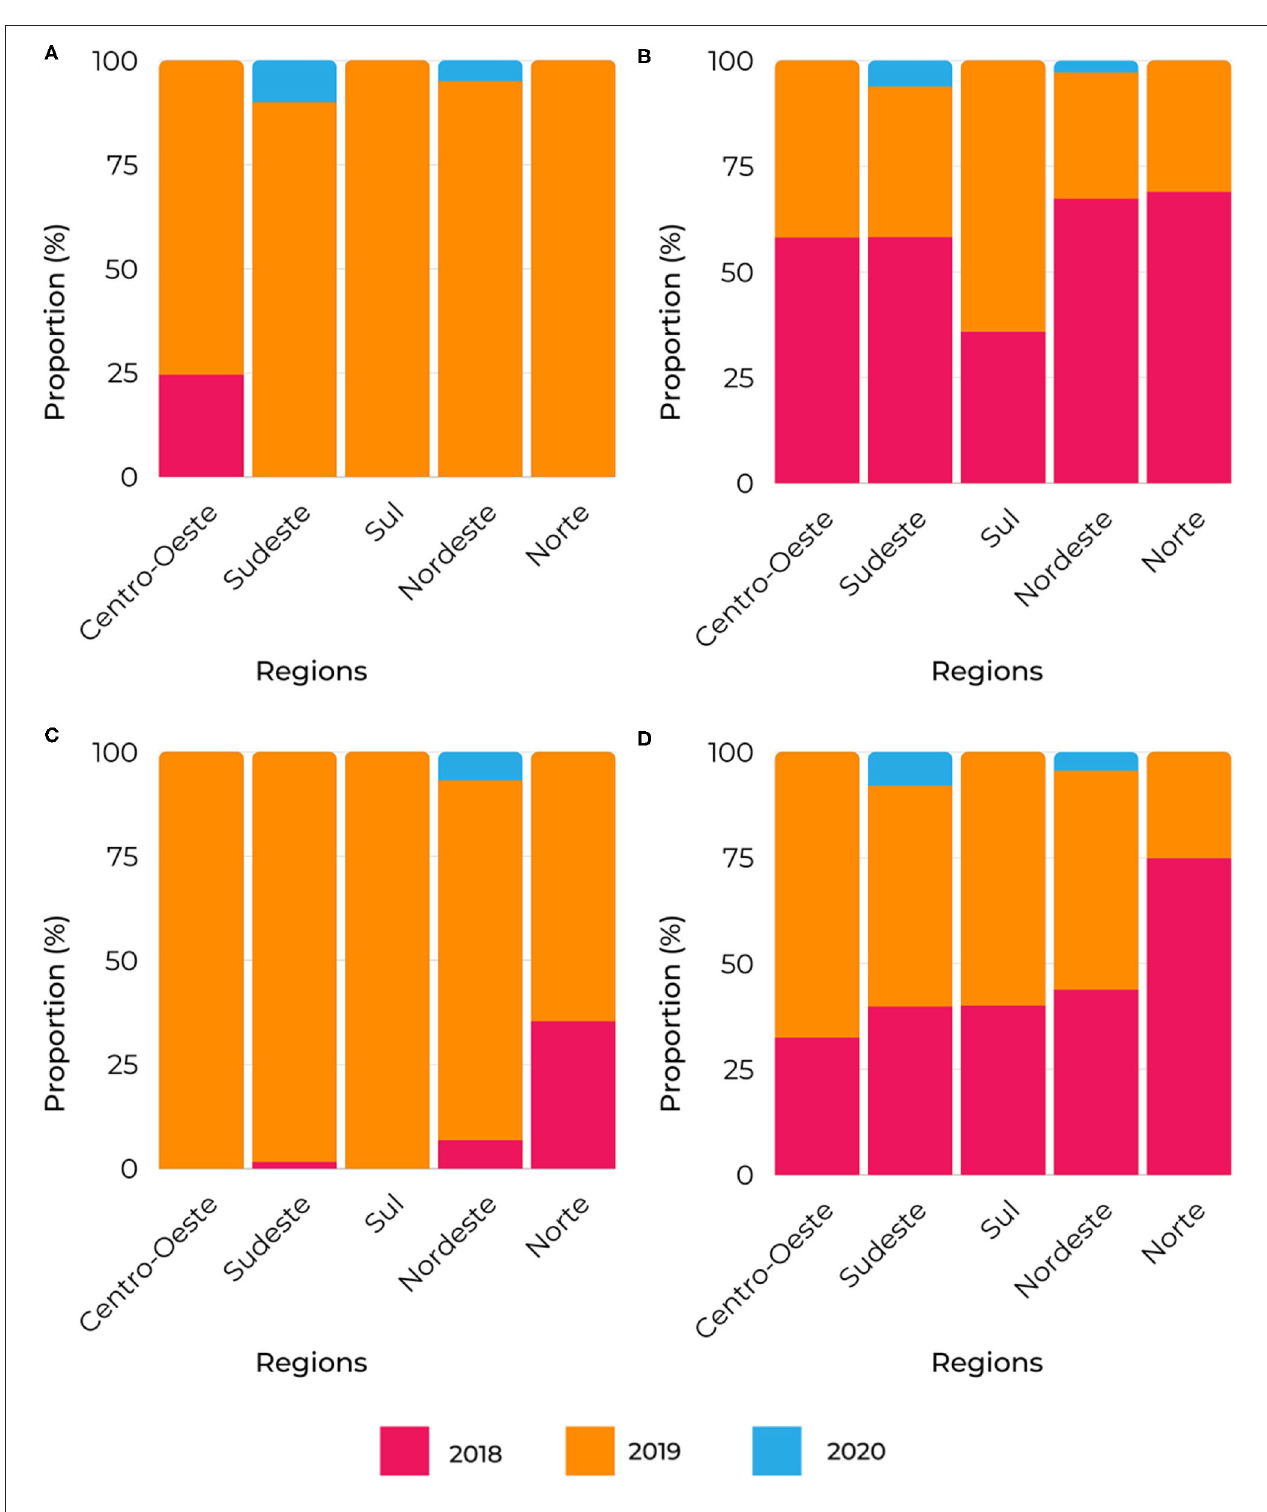
FIGURE 10 | Quadrigrams proportion of relevant terms segmented by region. (A) rapid response project implementation, supporter related response project, main activities developed territory, strategic aspects action supporter; (B) rapid syphilis care networks, congenital syphilis lower year, advances rapid response syphilis, related rapid response project; (C) highlighted priorities local management, highlighted local management related, syphilis pregnant congenital syphilis, national day against syphilis; (D) investigation vertical transmission committee, investigation vertical syphilis transmission, related rapid response syphilis.